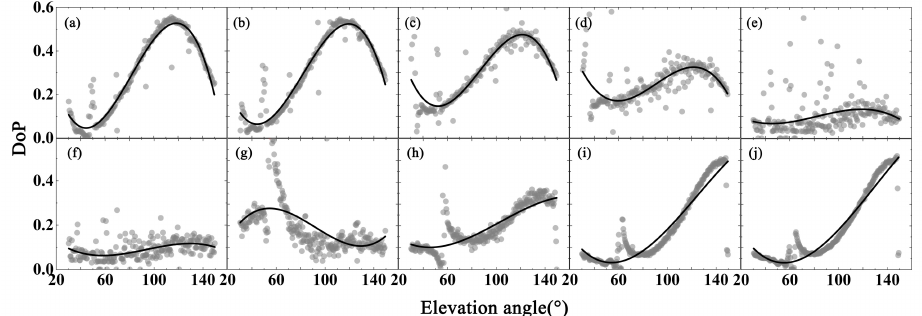
Figure 3. Degree of Polarization (DoP) corresponding to the direction parallel to the lunar-anti-lunar meridian. ( a – j ) corresponding to the recording time on 31 January in Table 2. The dots and solid lines represent the values of DoP and their fitted curve,